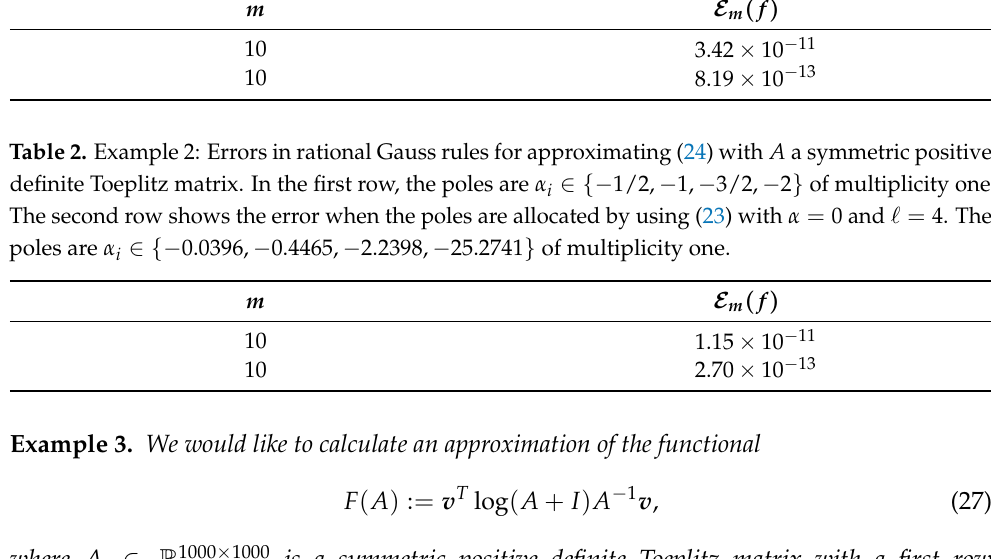
Table 1. Example 2: Errors in rational Gauss rules for approximating (24) with A is a symmetric positive definite Toeplitz matrix. For the first row, the distinct poles are α i ∈ {− 1, − 2 } , each of multi- plicity two. The second row shows the error when the poles are allocated with the aid of conformal mapping using (23) with α = 0 and (cid:96) = 2. Then the distinct poles are α i ∈ {− 0.1716, − 5.8284 } . m